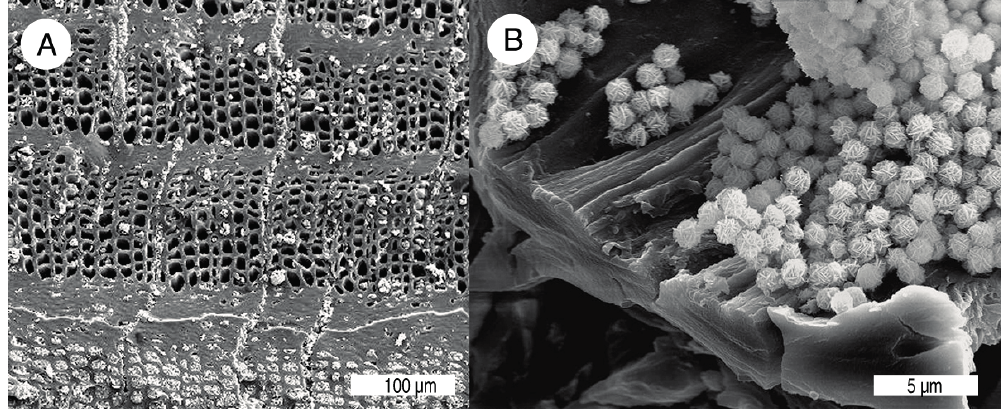
Figure 15. Partially carbonized wood showing three annual ring pairs. ( A ) Transverse view of wood with carbonized cell walls, individual cells mostly empty in two early-wood annual rings, porous opal in cells in one early-wood ring (lower part of photo); ( B ) High magnification view of cell containing opal-CT lepispheres partially filling a carbonized tracheid. Locality 2 (Royal Peacock opal